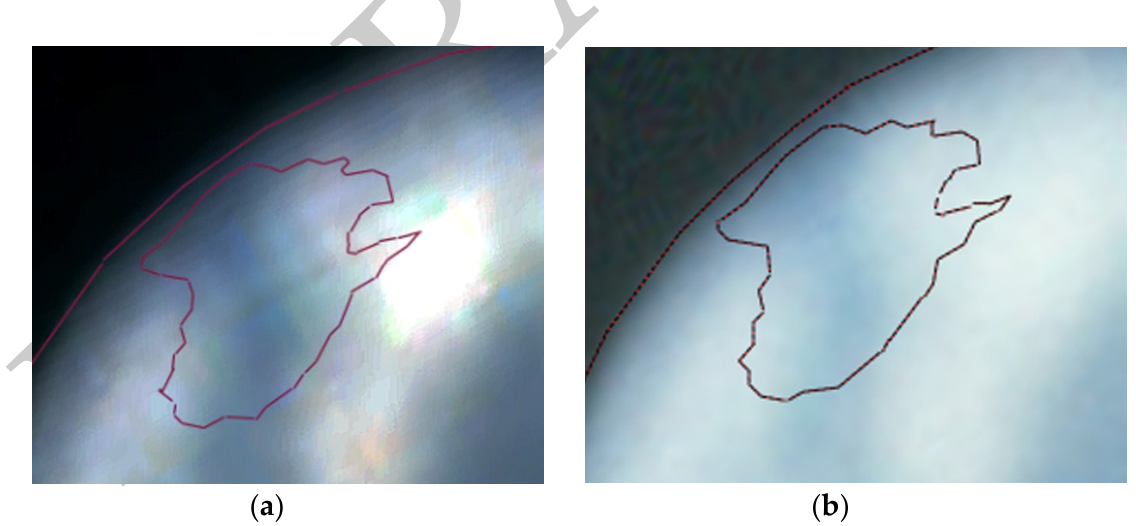
Figure 7. Australia’s position at the time of photo capture: ( a ) an enlargement of Figure 6b of photo AS17-134-20384, found in the Apollo 17 Image Library of the official NASA webpages; ( b ) relative enlargement of photo AS17-134-20384, found in the Apollo 17 photos in the NASA commons Flickr account [13].